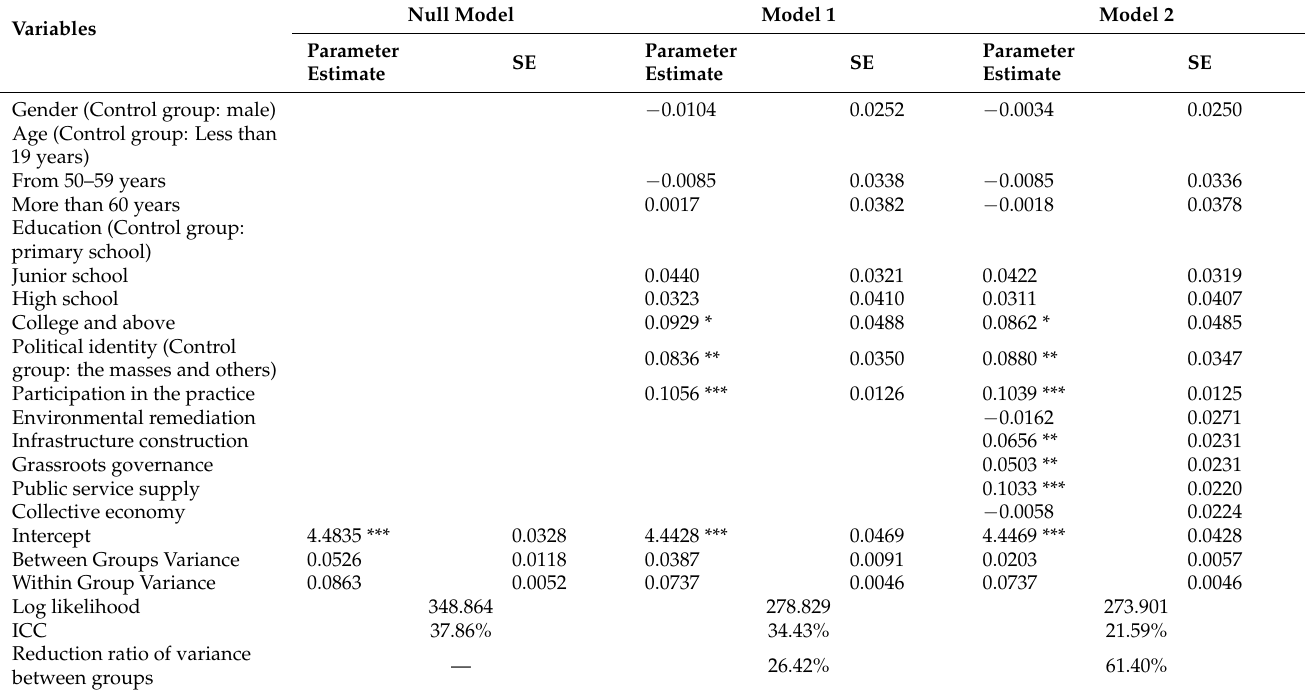
Table 5. Multilevel modelling on respondents’ satisfaction with SRD